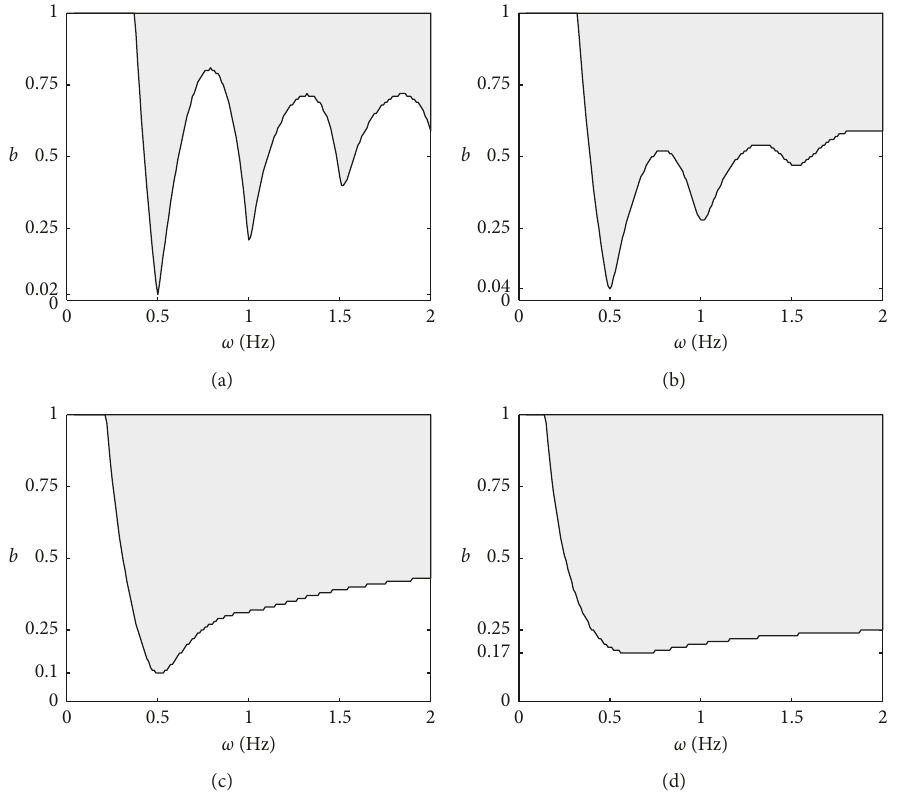
0 . 005 and (cid:29)